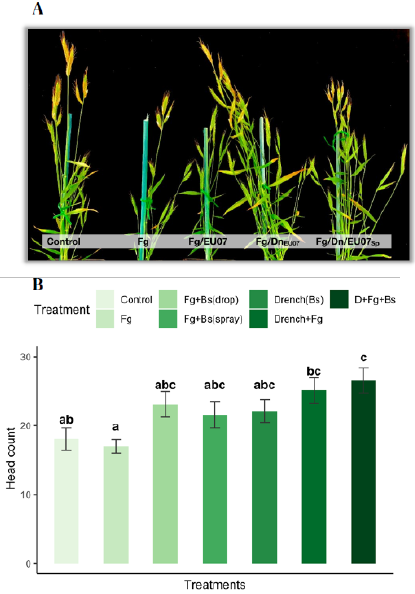
Figure 11. Bd-21 produced more spikes when treated with Bacillus EU07. ( A ) Bd-21 plants were inoculated with a 25 µL drop of macroconidia of Fg ( 10 6 /mL). The treatments were: Control (water), Fg alone, Fg/EU07 inoculated and treated with Bacillus drop. Fg /Dn EU07 : Fg inoculated plants and drenched with EU07. Fg /Dn/EU07 sp : Fg inoculated plants, drenched with EU07 and treated with EU07 spraying the spikelets. Plants drenched with EU07 ( Fg /Dn EU07 and Fg /Dn/EU07 sp ) produced a much higher number of spikelets than that by the control and the non-drenched plants. ( B ) Number of heads per plant of the Bd-21 treated with Fg -K1-4 and EU07. Data were from one independent experiment of at least seven replicates and shown as the mean ± SE. Experiments were repeated three times and similar results were obtained. Bars clusters with different letters were significantly different according to Tukey’s Test (α < 0.05) following one-way ANOVA. n = 66.